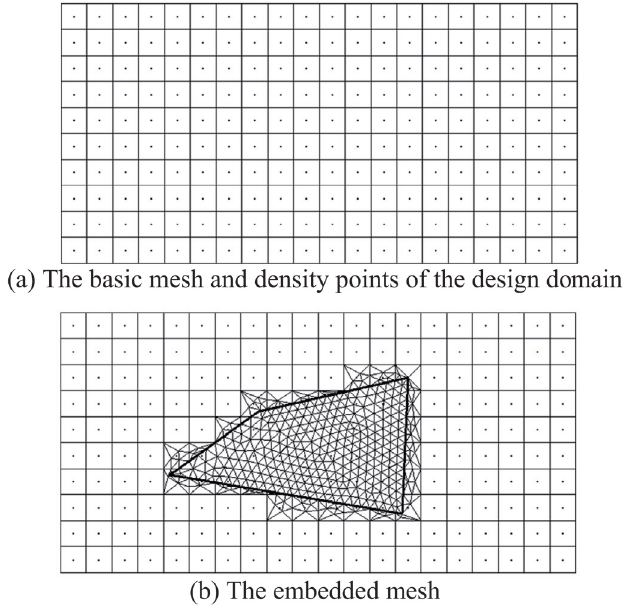
Fig. 11. Modeling of the basic mesh and embedded